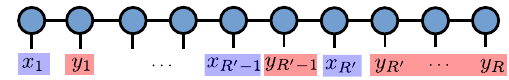
FIG. 3. Matrix product state representing a 2D space spanned by x and y . The expansion can be truncated at the right edge.